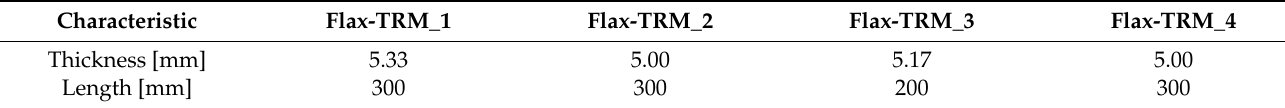
Table 3. Geometric characteristics of Flax-TRM.